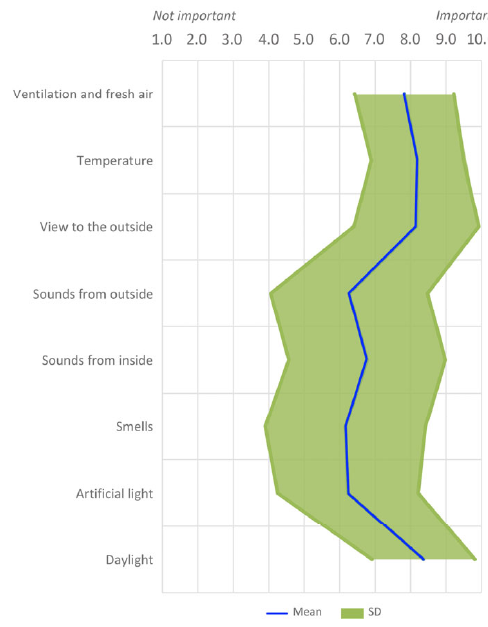
Figure 1. IEQ preferences of study places.